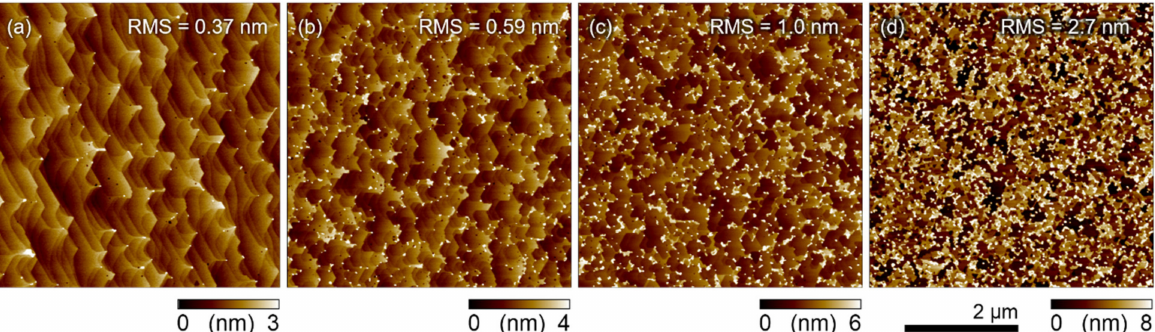
Figure 8. AFM images of the FFA Sp-AlN templates deposited at sputtering pressures of: ( a ) 0.2 Pa, ( b ) 0.4 Pa, ( c ) 0.6 Pa, and ( d ) 0.8 Pa. The scale bar is the same in all the